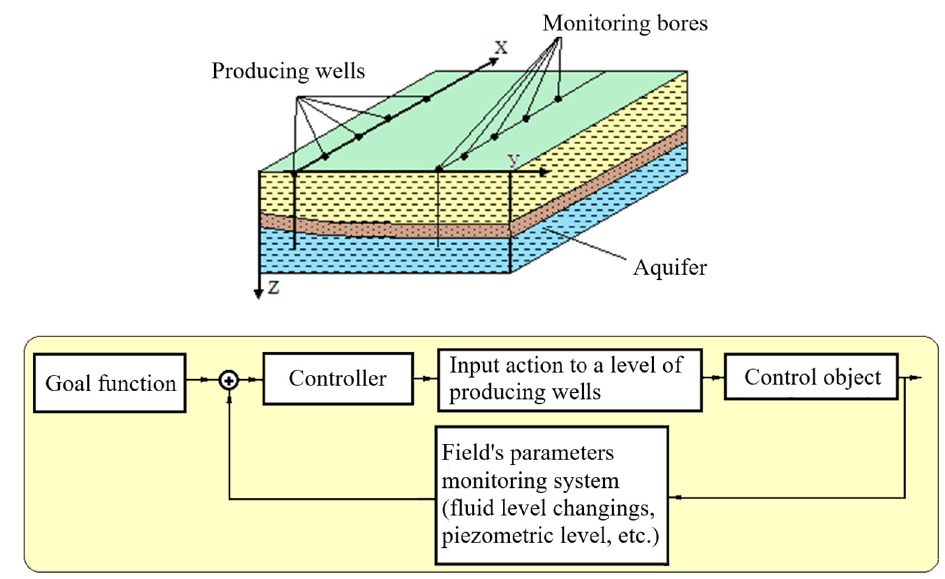
Figure 1. Conceptual model of the mineral water field control process.